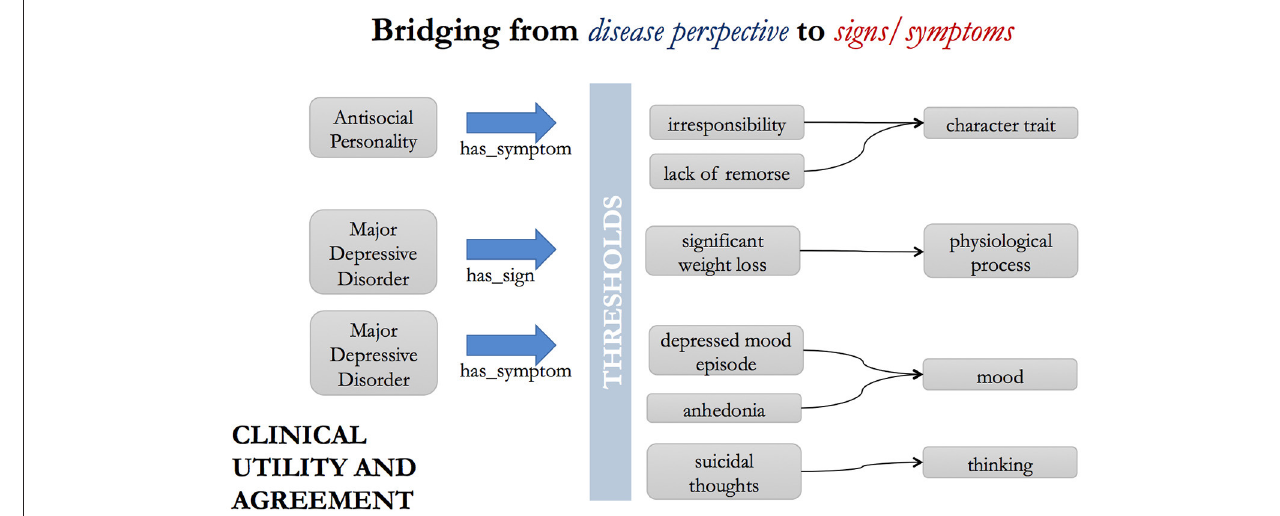
FIGURE 5 | Bridging from the disease/disorder perspective to the sign/symptom